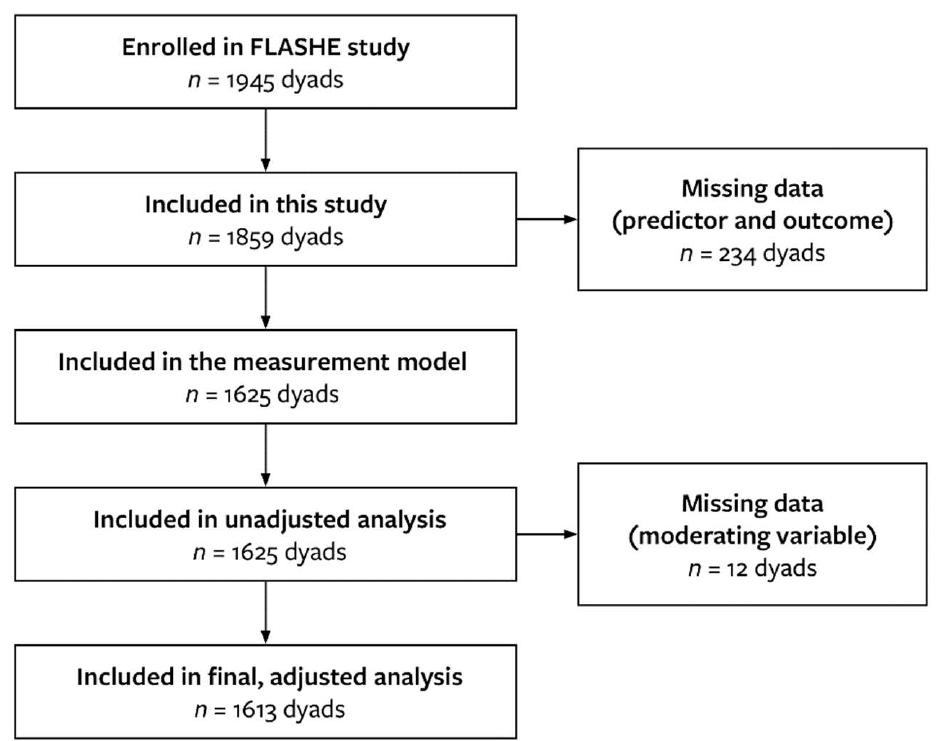
Figure 1. Flow diagram showcasing sample sizes for analysis stages. Listwise deletion was used to take care of missing data. Table 1. Descriptive statistics of demographic variables of parent and adolescent dyads.